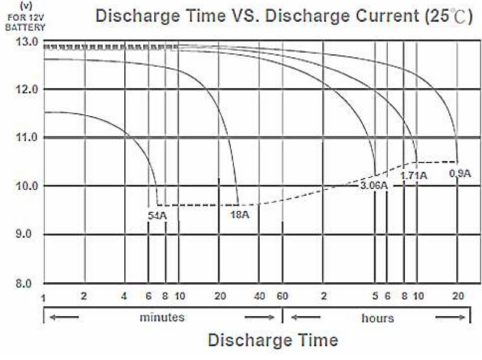
Figure 9. Characteristic curve of the